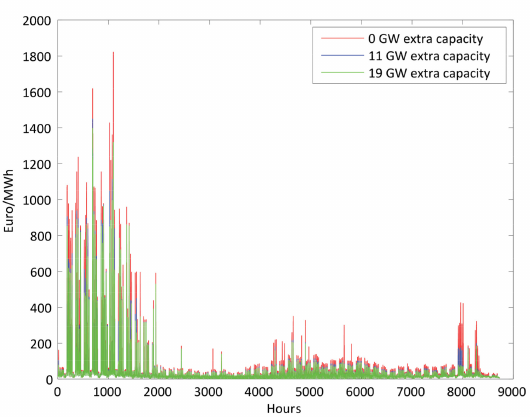
Figure 12. Prices hour by hour for SORLANDET averaged over 75 years with stochastic